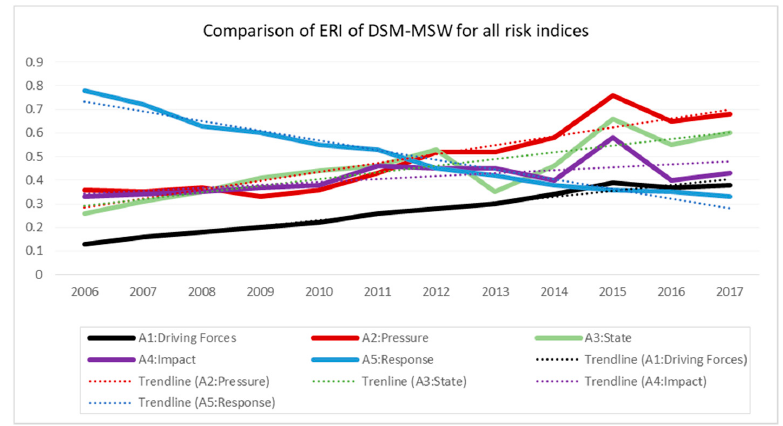
Figure 7. Comparison of ERI of Dar es Salaam MSW for all indices.